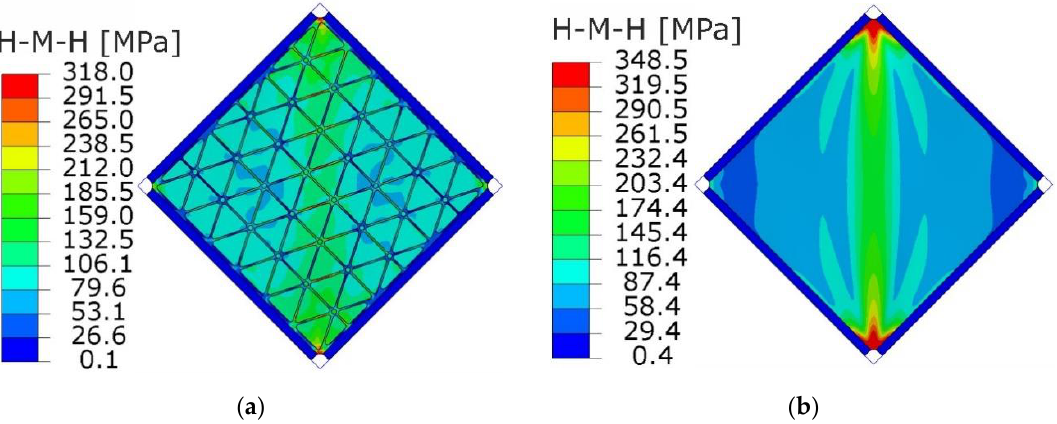
Figure 22. Deflection fields [mm] obtained from FEM analyses at the load level causing the start of plastic deformation (q = 37 N / mm): ( a ) sti ff ened plate, ( b ) smooth plate.